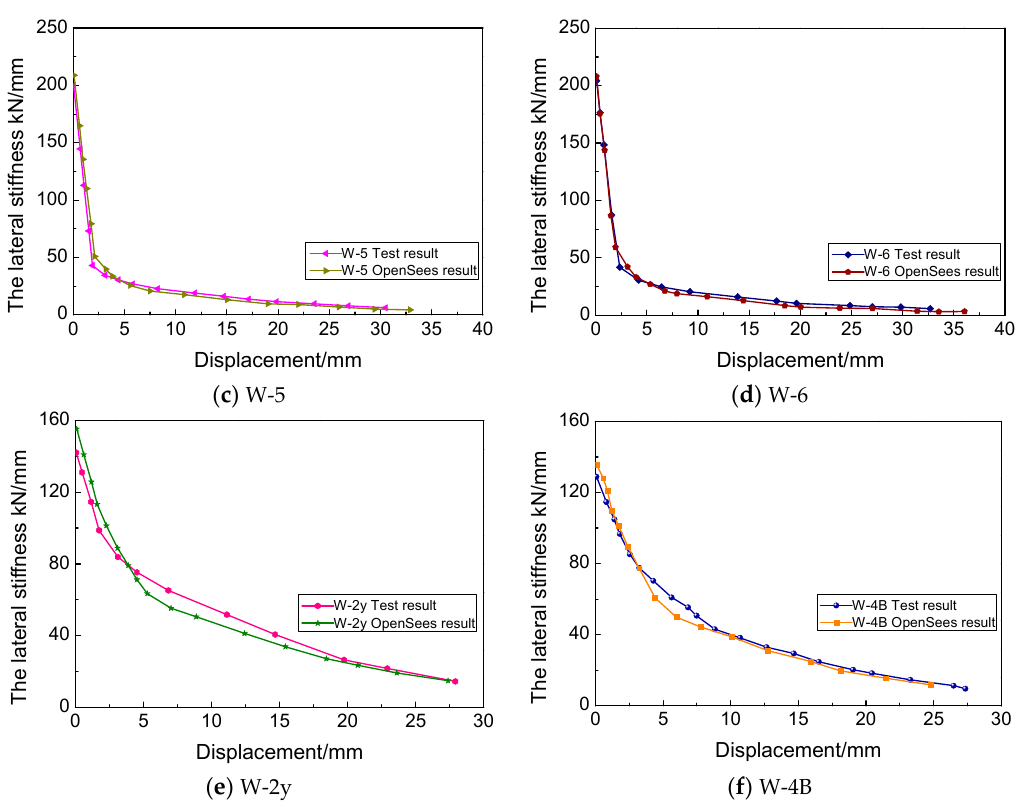
Figure 10. Comparison of the test results and the calculated results of the stiffness degradation curves.